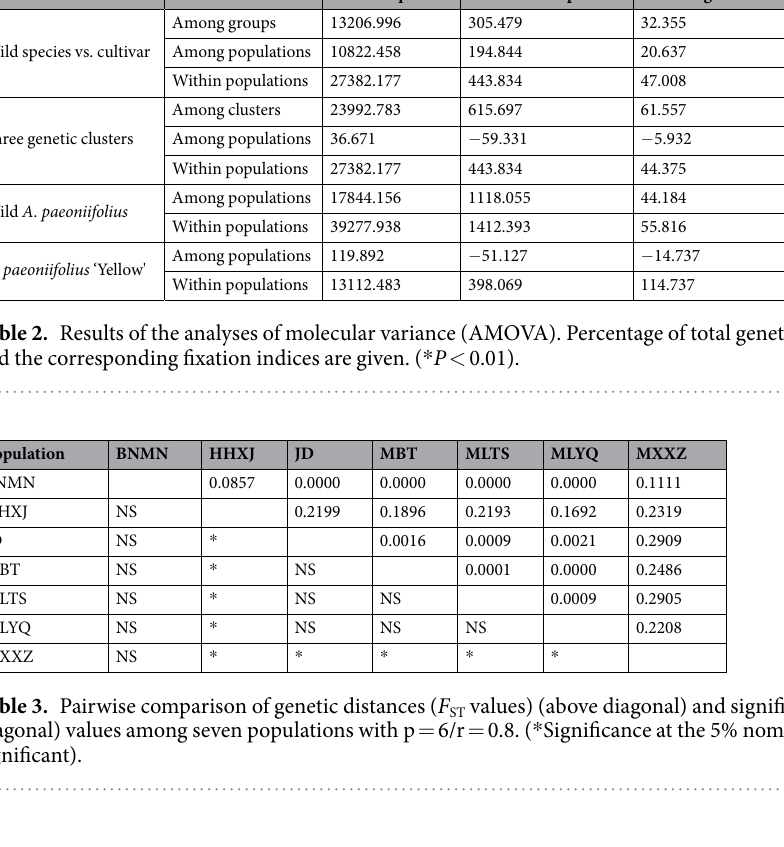
Taxon Source of variation Sum of Squares